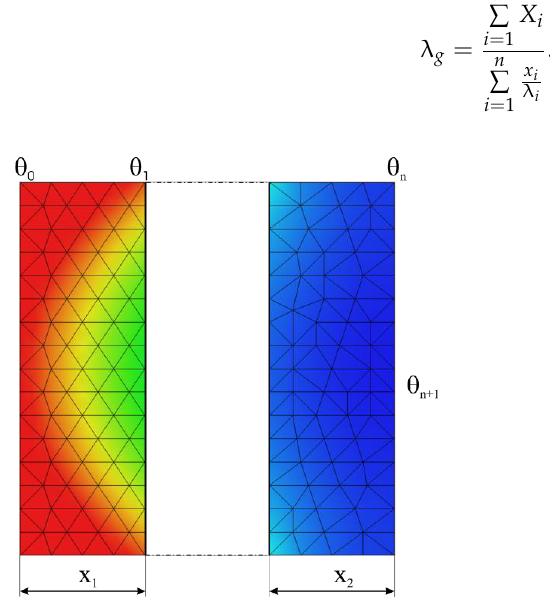
Figure 10. Regarding the global transmissivity α g .